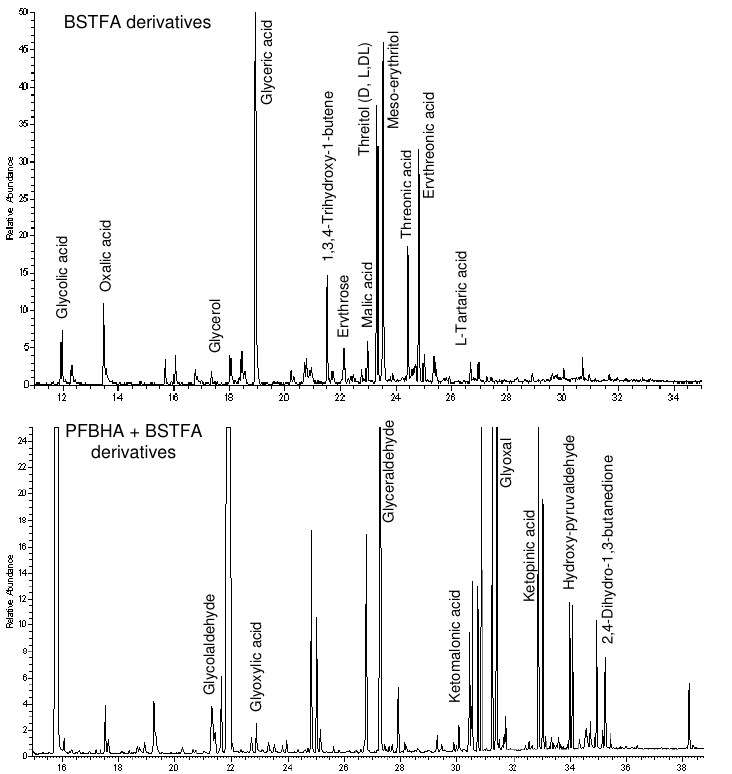
Figure 1. Total ion chromatograms of organic extracts from an irradiated 1,3-butadiene/NO x /air mixture as BSTFA (top) and PFBHA + BSTFA (bottom) derivatives.